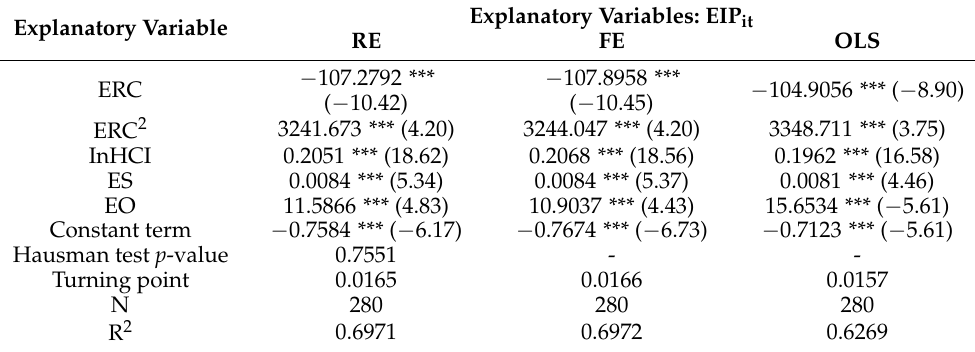
Table 3. Panel model estimation results of the effect of command-and-control environmental regula- tion on eco-innovation performance.